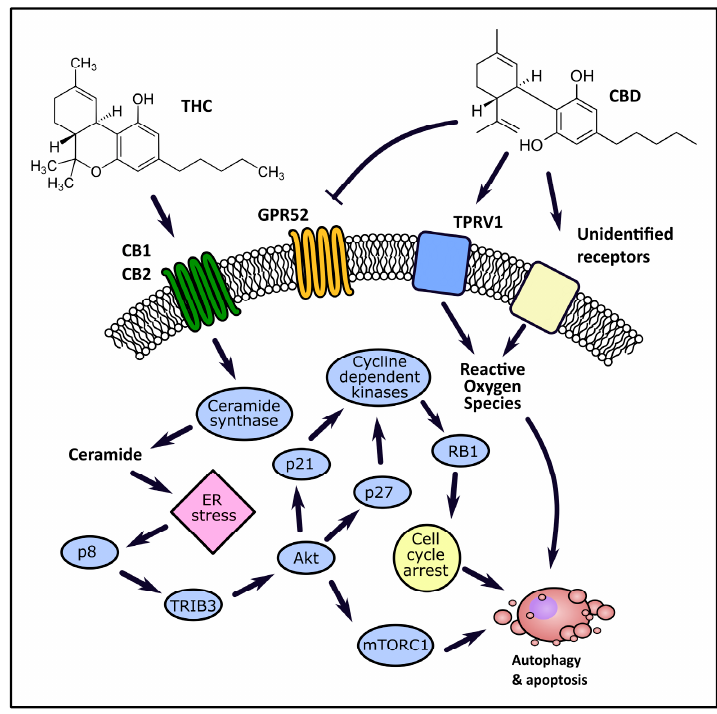
Figure 2. The overview of pathways involved in the anticancer activity of cannabinoids.